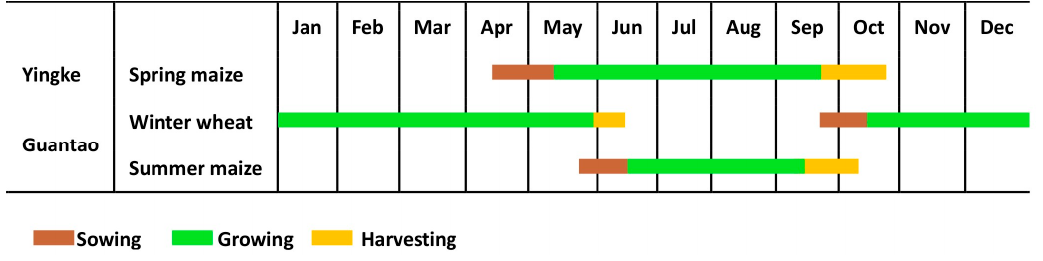
Figure 3. Crop calendars for the Yingke and Guantao Experimental Areas.